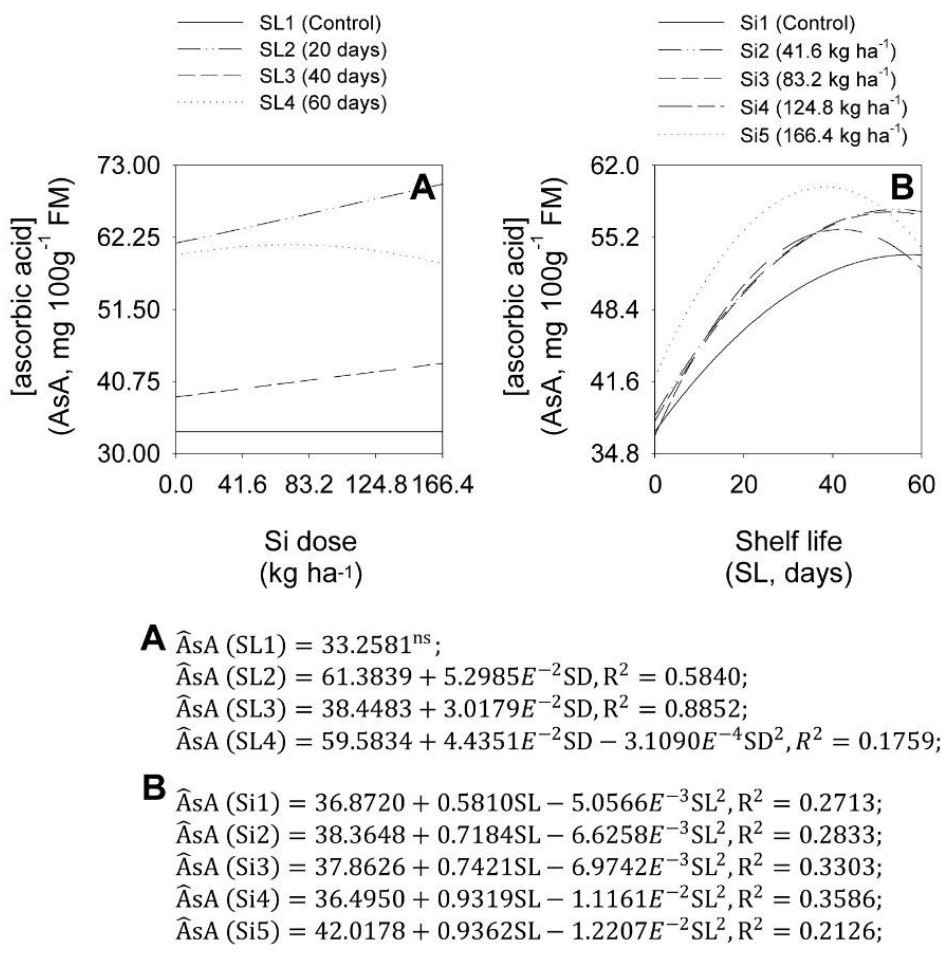
Figure 11. Effect of the interaction between Si dose levels (SD) ( A ) and shelf life (SL) ( B ) on ascorbic acid concentration (AsA) in ‘Rio da Antas’ onion bulbs.